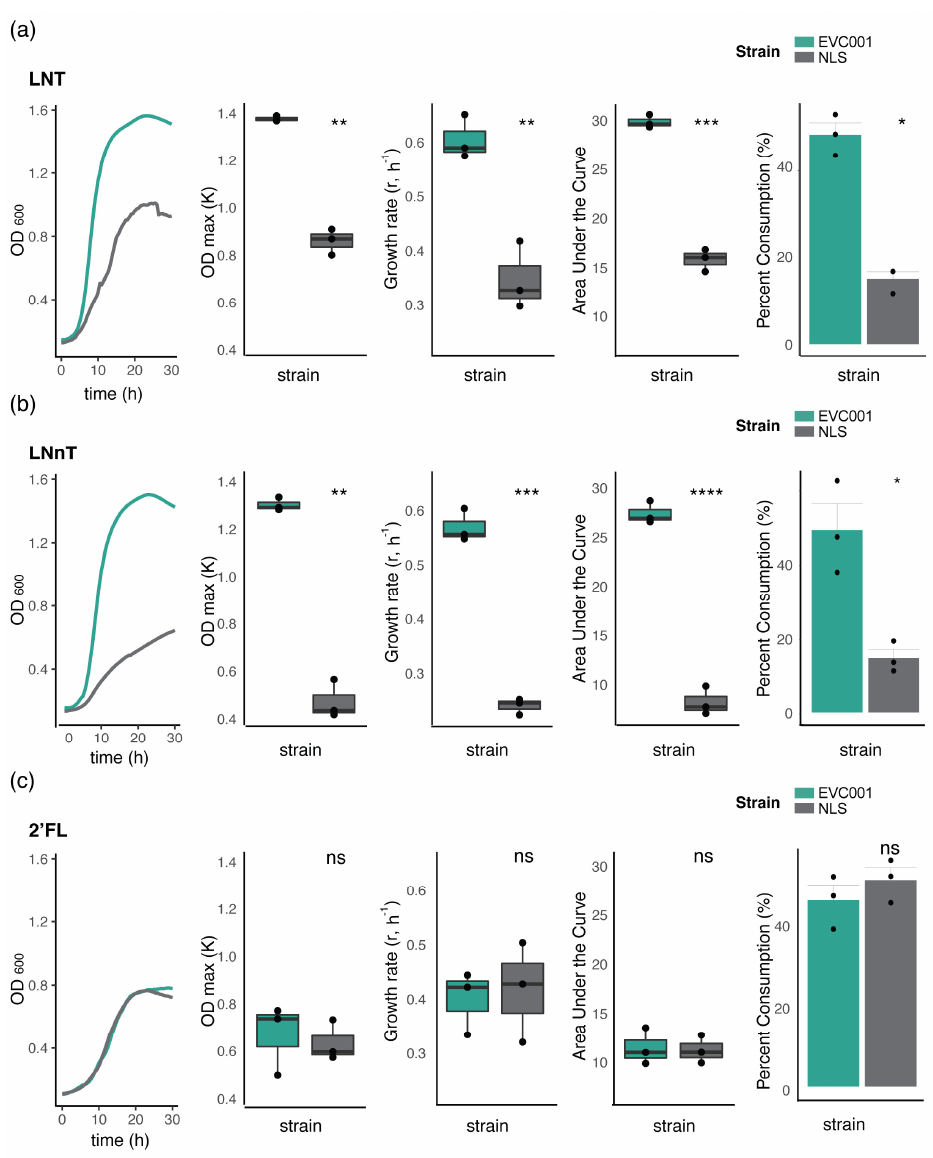
Figure 3. Growth on HMOs of select B. infantis strains. Growth kinetics and HMO consumption of B. infantis EVC001 (H5 positive, Group 1) and B. infantis NLS (H5 negative, Group 2) in mMRS medium containing ( a ) lacto- N -tetraose (LNT), ( b ) lacto- N -neotetraose (LNnT), or ( c ) 2 (cid:48) -fucosyllactose (2 (cid:48) -FL) as the carbon source. Growth indicators were compared, with statistical significance determined by Student’s t -test indicated with asterisks; ns: not significant, * p < 0.05, ** p < 0.01, *** p < 0.001 and **** p <